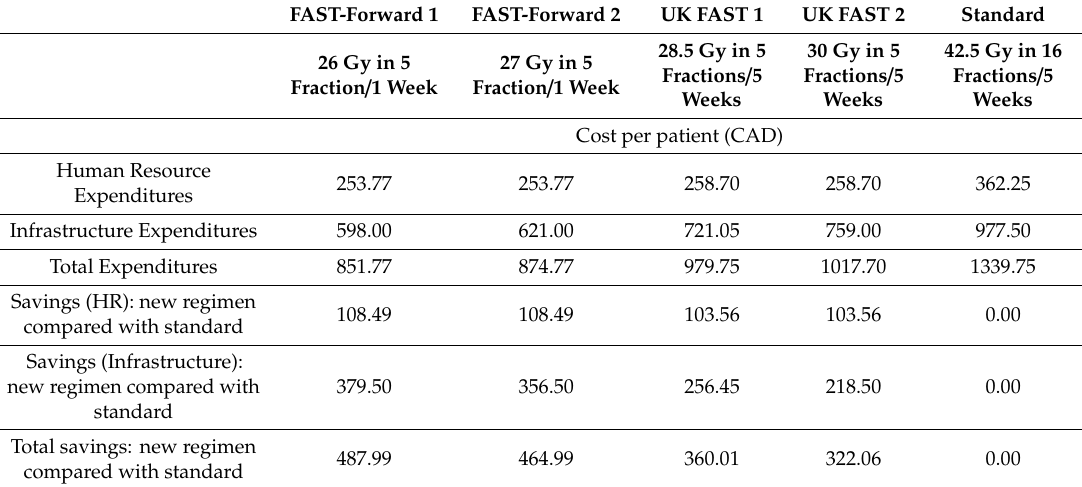
Table 3. Total cost per patient associated with standard and hypofractionated radiotherapy.